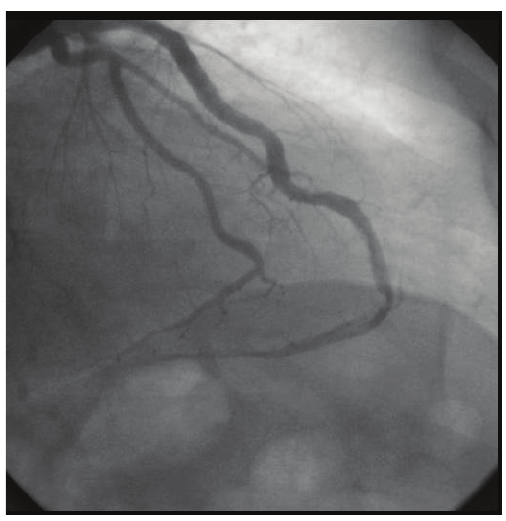
Figure 3: Coronary angiogram showing left anterior descending coronary artery in the right anterior oblique view. LAD is long wrapped around the apex and continues as the posterior descending artery. There is an eccentric plaque with thrombus at the apex where it continues as PDA.